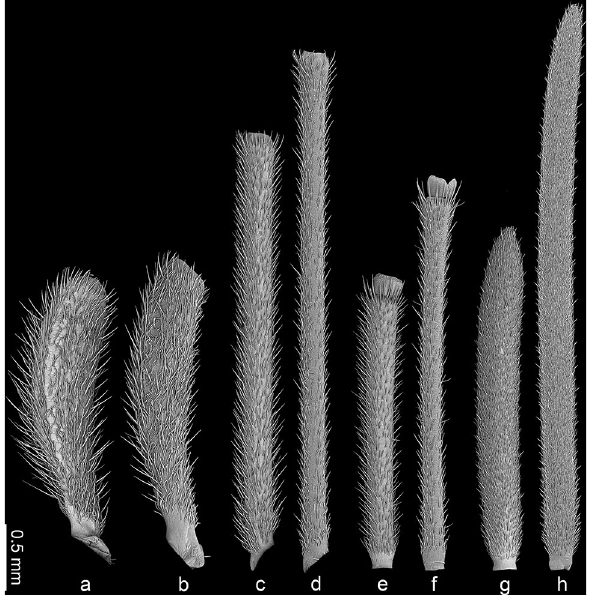
Figure 3. The particular antennomeres of L. occidentalis (a, c, e, g) and L. zonatus (b, d, f, h); scape (a, b), pedicel (c, d), basiflagellum (e, f), distiflagellum (g,